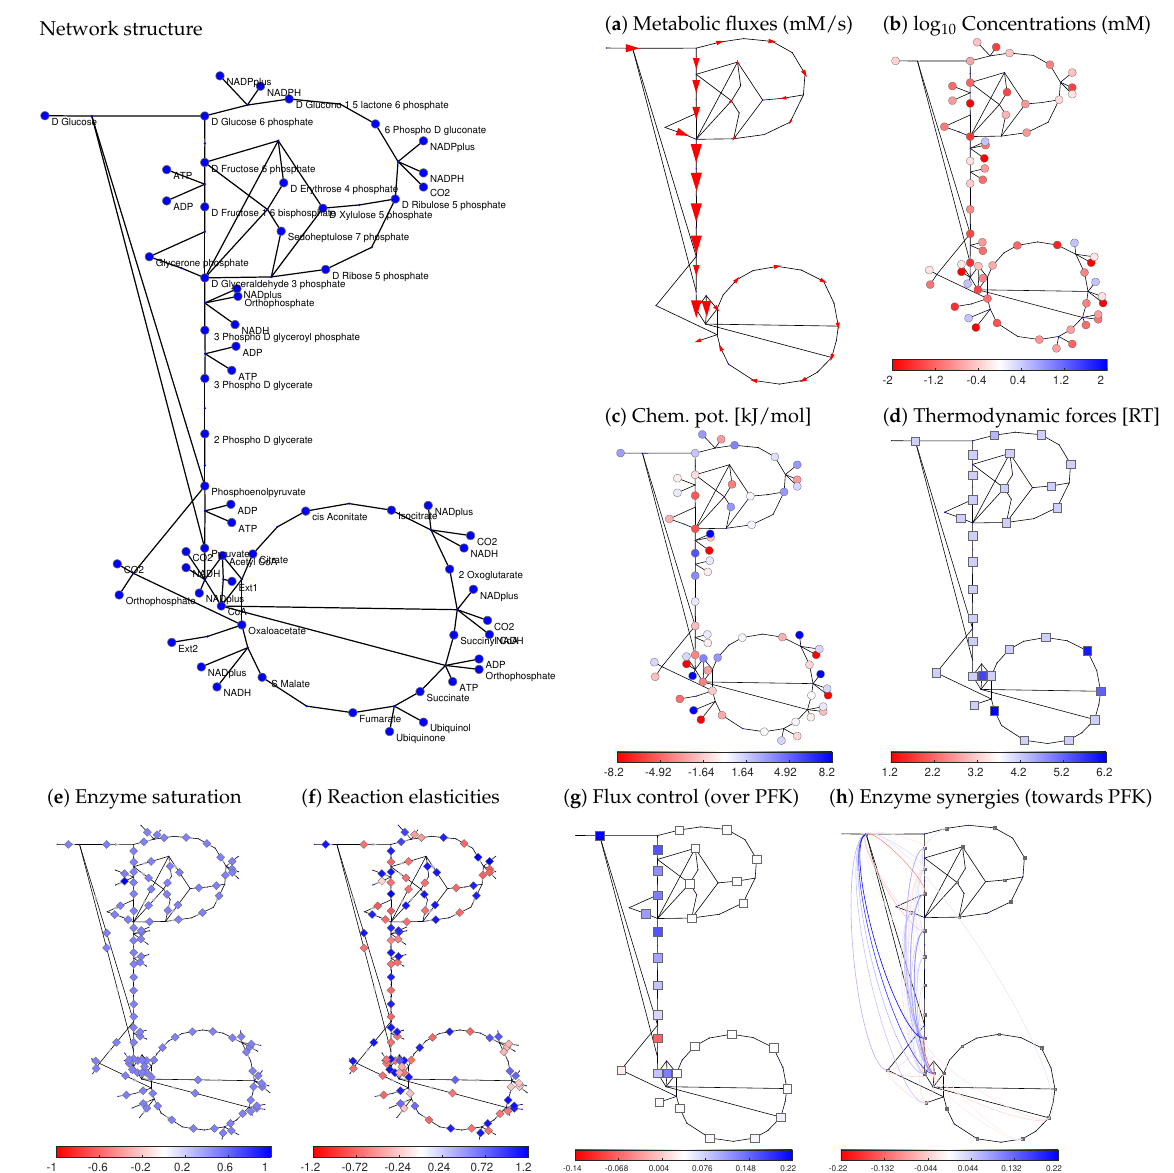
Figure 3. Systematic model construction by STM. Model of central carbon metabolism in Escherichia coli (for model details, see Data Availability). Network structure and flux data (from cells respiring on glucose) were taken from [51]. The panels show different types of variables obtained during model construction following the schema in Figure 2 (circles: metabolites; arrows and squares: reactions). By repeatedly sampling the basic variables and computing the others, a model ensemble can be constructed. ( a ) Thermodynamically feasible fluxes (red arrows) obtained by flux minimisation (data from [53]); ( b ) metabolite log-concentrations. Metabolite concentrations and thermodynamic forces were determined by thermodynamic balancing [54] of metabolite and reaction Gibbs free energy data. ( c ) chemical potentials; ( d ) thermodynamic forces in units of RT; ( e ) saturation values, set to standard values of 1 . Alternatively, the saturation values could be determined from data or be sampled at 2 random between 0 and 1; ( f ) scaled reaction elasticities ˆE v l c ; ( g ) scaled control coefficients ˆ ( C ) r PFK v i l for the flux in upper glycolysis (phosphofructokinase reaction) as the target variable; ( h ) enzyme synergies (given by scaled second-order control coefficients) for the glycolytic flux. Positive values are shown in blue, negative values in red, zero values in white. For clarity, only enzyme synergies in the outer 5 percent quantiles are